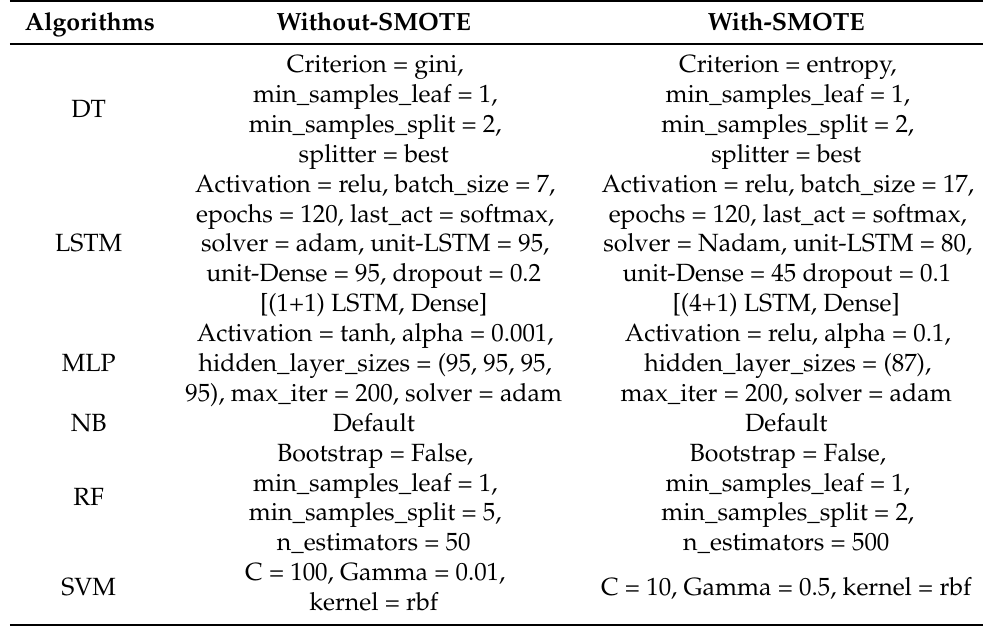
Table 3. Exp1 Scores (Precision, Recall,